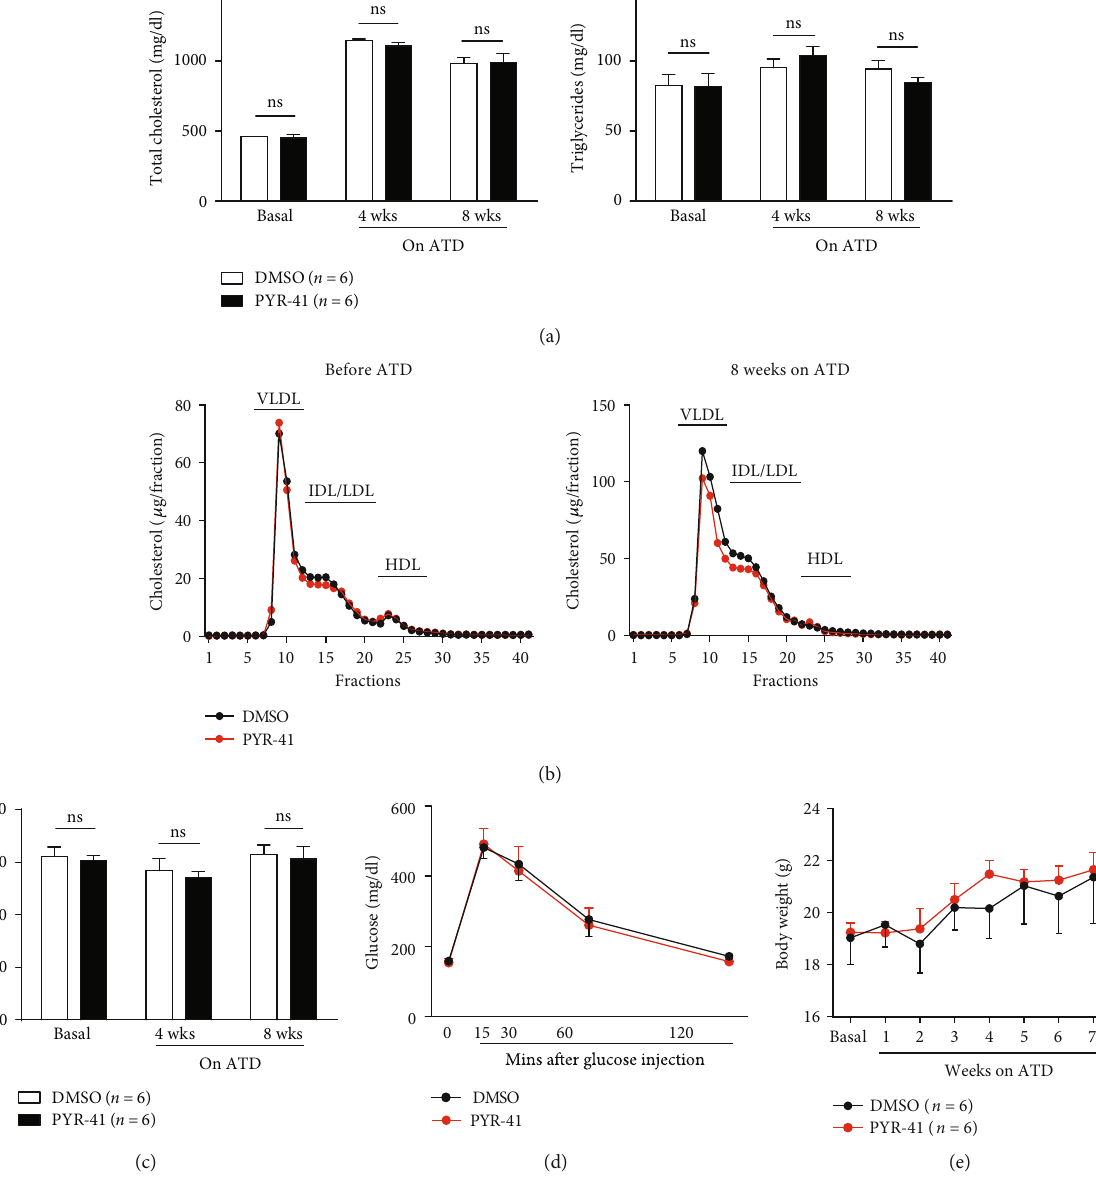
Figure 2: Inhibition of UBA1 did not alter the main metabolic parameters during diet-induced atherogenesis in Apoe-/- mice. (a) Plasma total cholesterol and triglyceride levels before and after the atherogenic diet feeding. (b) Plasma lipoprotein pro fi les fractioned by FPLC before (left) and after (right) the atherogenic diet feeding. (c) Plasma glucose levels before and after the atherogenic diet feeding. (d) Insulin resistance detected by the glucose tolerance test after 8 weeks on the atherogenic diet. (e) Body weight gain during the atherogenic diet feeding. n = 6 per group; ns: not signi fi cant; ATD: atherogenic